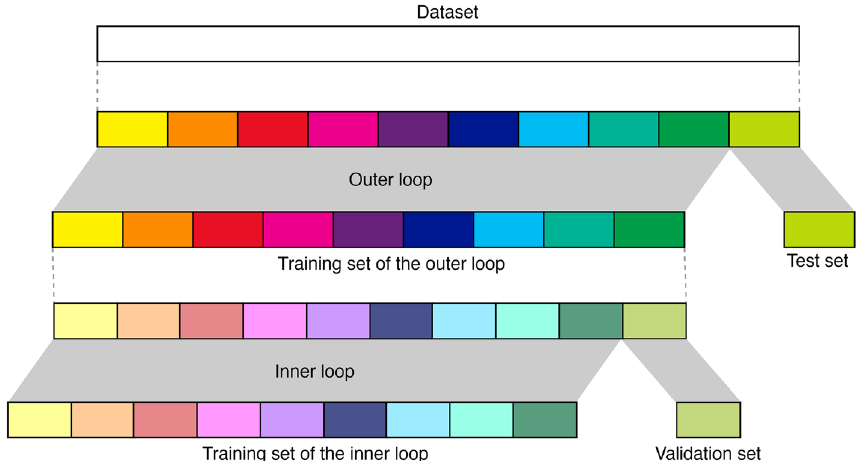
Figure 7. A scheme of tenfold nested CV is represented. The inner CV loop is used to perform feature selection, optimize hyper-parameters and select the best classifier, whereas the outer loop estimates the selected models’